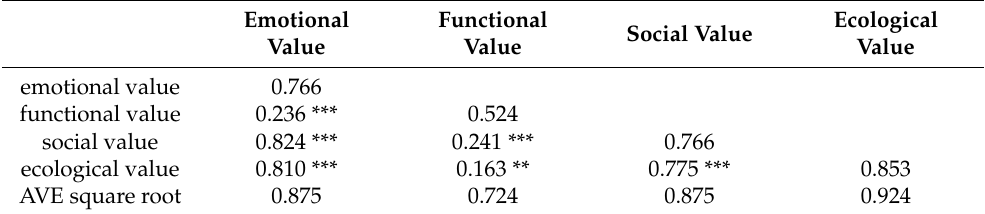
Table 8. Discriminant validity of the perceived value.